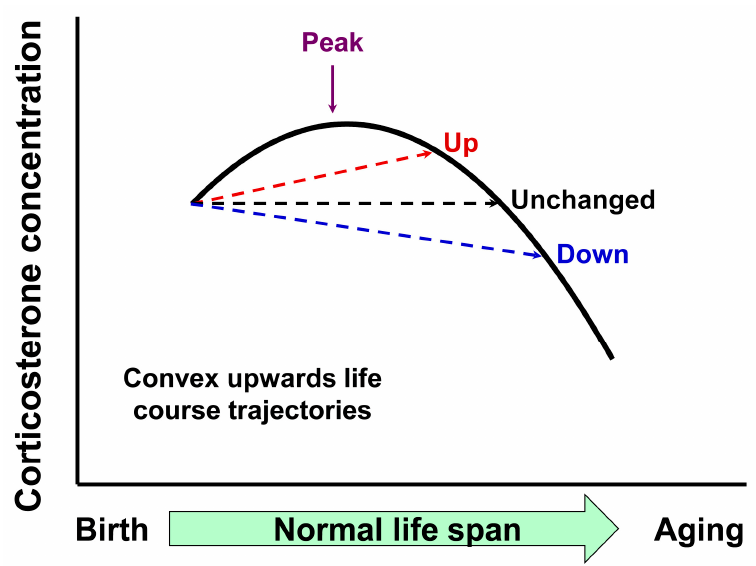
Figure 6. The importance of categorical life course points in aging studies. The figure exemplifies the lifetime corticosterone concentration having a peak at approximately mid-life (purple arrow). If only two samples are obtained, the possibility exists of false conclusions as to whether values rise (red arrow), are unchanged (black arrow) or fall (blue arrow) with age. Hence, data interpretation in the lifespan trajectory depends on the time at which the sample is obtained.